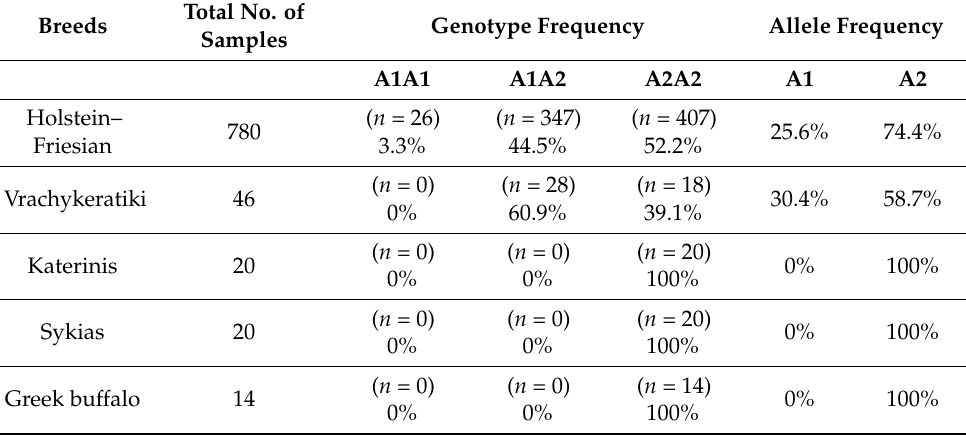
Table 1. Gene and genotype frequency of β -casein gene. Total No. Breeds